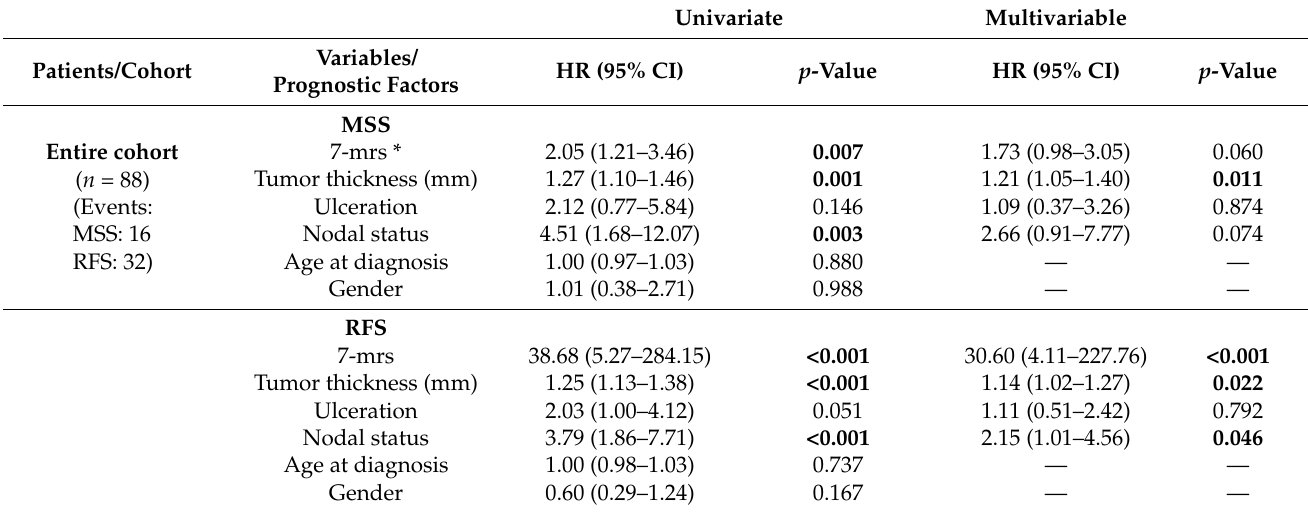
Table 2. Univariate and multivariable Cox regression analysis. Univariate